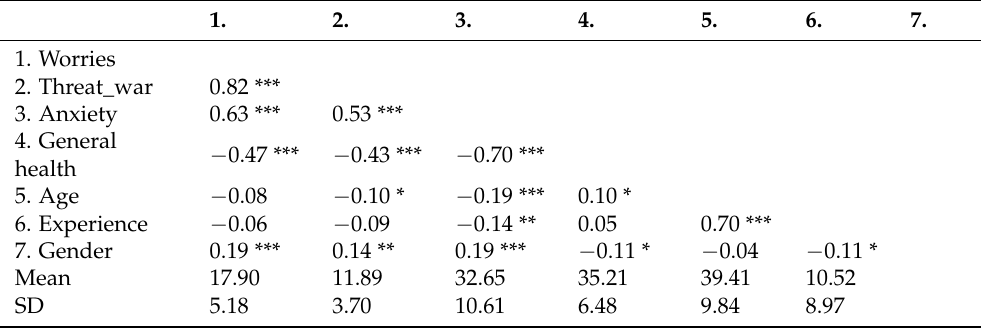
Table 3. Zero-order correlations among the main study variables.